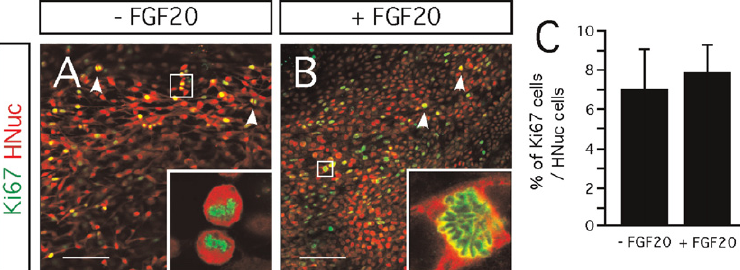
Figure 5. Effect FGF-20 on cell proliferation. ( A , B ) Representative images of Ki67- and HNuc-positive cells in 3 weeks differentiated hESCs/PA6 co-cultures – FGF-20 (A) and þ FGF-20 (B). Arrowheads point on cells going through mitosis. ( C ) Graphic representation of the percentages of Ki67-positive cells among HNuc- positive cells in 3 weeks differentiated hESCs/PA6 co-cultures (cid:2) FGF-20 and þ FGF-20. Average (cid:1) SEM. Distance bars: 100 m